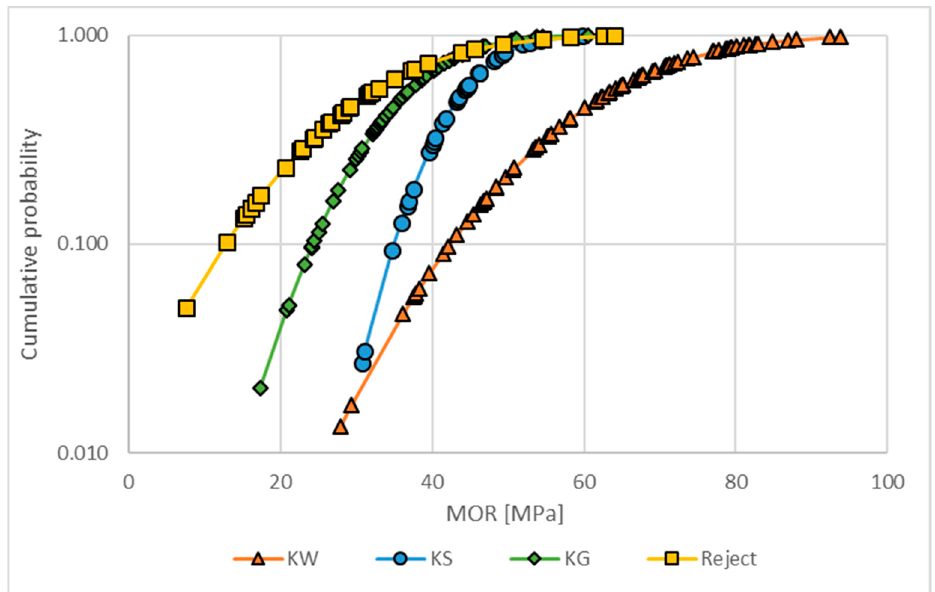
Figure 5. Distribution of static bending strength of different strength grades for Scots pine timber in a logarithmic scale.